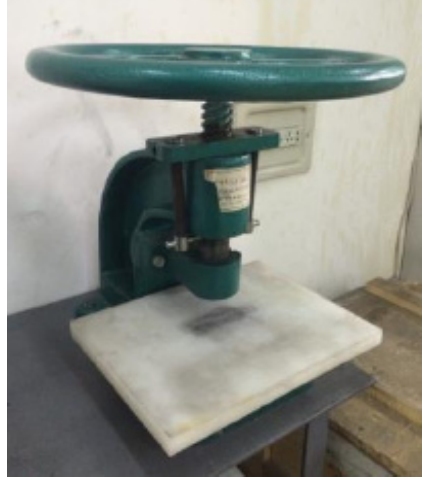
Figure 3. Specimen